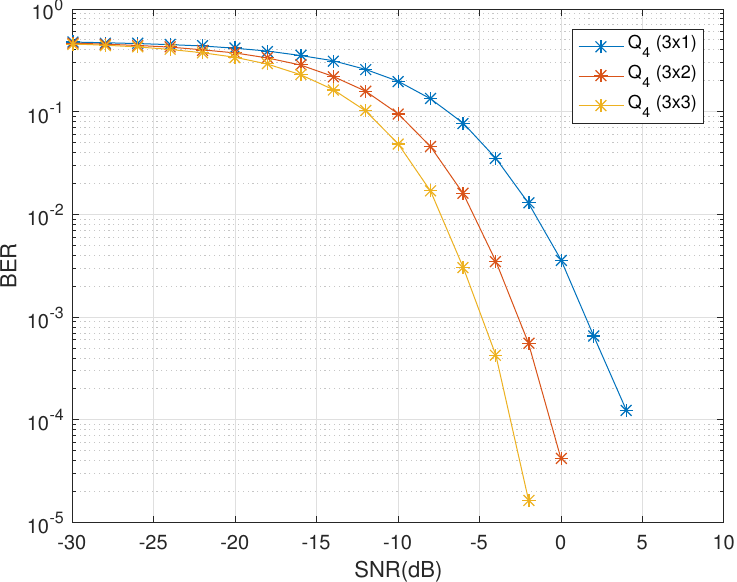
Figure 5. BER vs. SNR performance of Q 4 for one, two and three receive dual-polarized